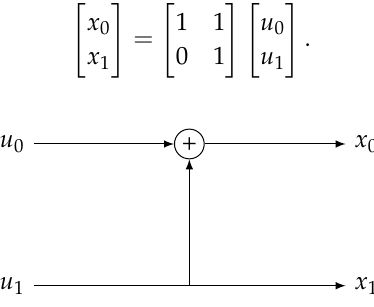
Figure 4. Building block of polar codes.